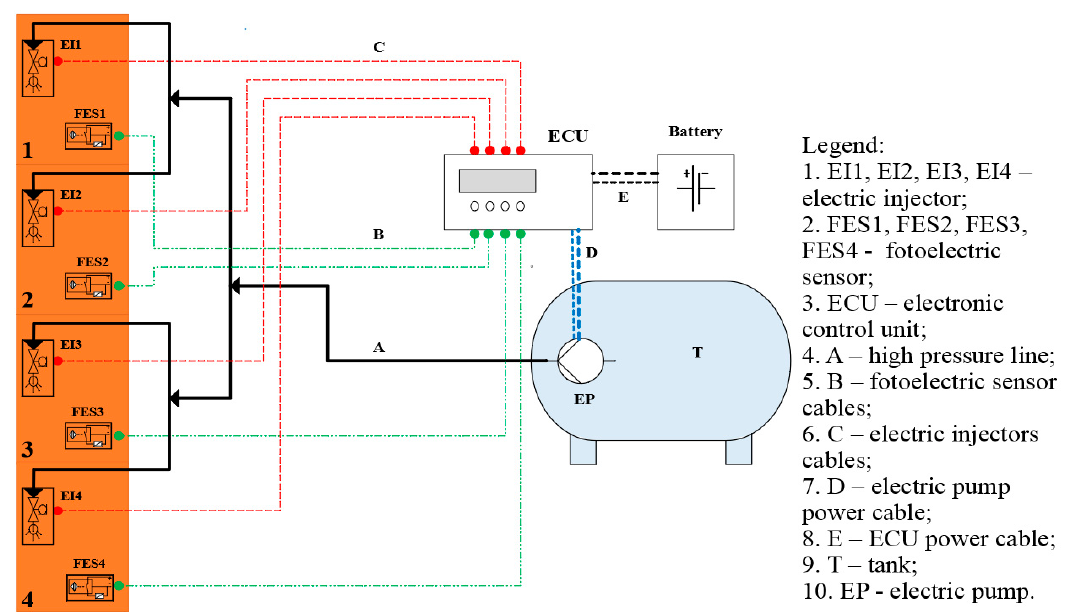
Figure 3. The electronic device EUKU-01 schematic (Source: Original).